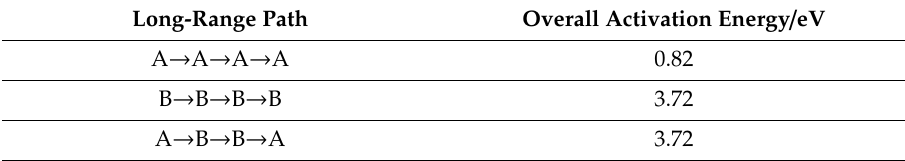
Figure 5. Enthalpy of solution of MO, (M = Fe, Co, Ni, Zn, Ca, Sr and Ba) with respect to the M 2+ ionic radius in Mg 6 MnO 8 .